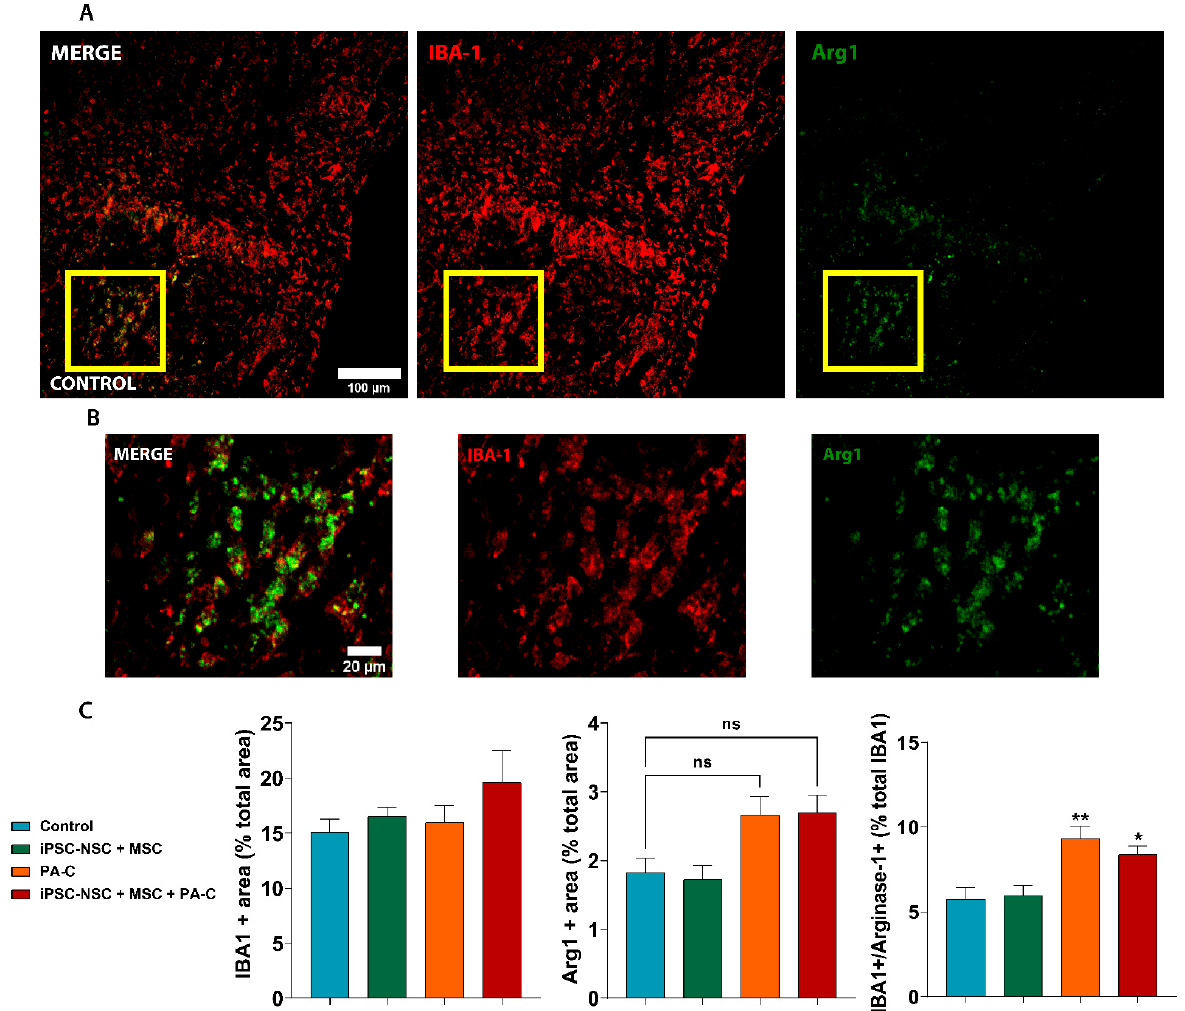
Figure 8. PA-C and PA-C combined with iPSC-NSC + MSC transplantation prompt microglial polarization towards an anti-inflammatory profile. ( A ). Representative immunostaining images of IBA1 (microglia marker; red) and Arg1 (anti-inflammatory marker; green) (scale bar = 100 µm). ( B ). Magnified images of the indicated area in A with a yellow square for IBA1 and Arg1 staining (scale bar = 20 µm) ( C ). Quantification of total microglia, positive for IBA1 (left panel) and the total number of cells positive for Arg1 (central panel), which are represented as the percentage of positive cells of the tissue area analyzed; Right panel represents the percentage of activated microglia, co-expressing IBA1 and Arg1, represented as a percentage of the total microglia (positive for IBA1). Quantitative data expressed as mean ± S.E.M determined by one-way ANOVA with Tukey’s multiple comparison test (n = 3). * p < 0.05, ** p < 0.01 vs. control; ns (non-significant) as